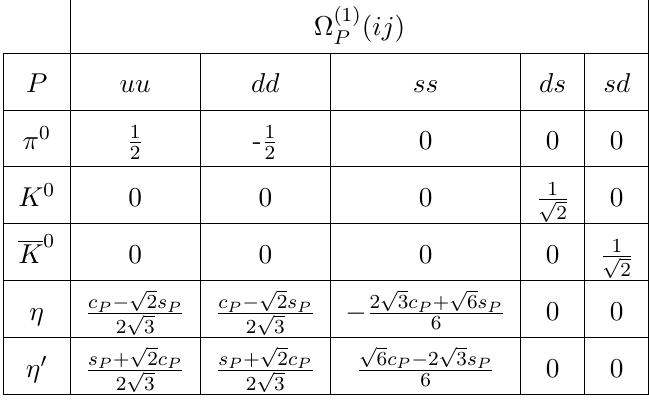
Table 4 . Factor Ω (1)